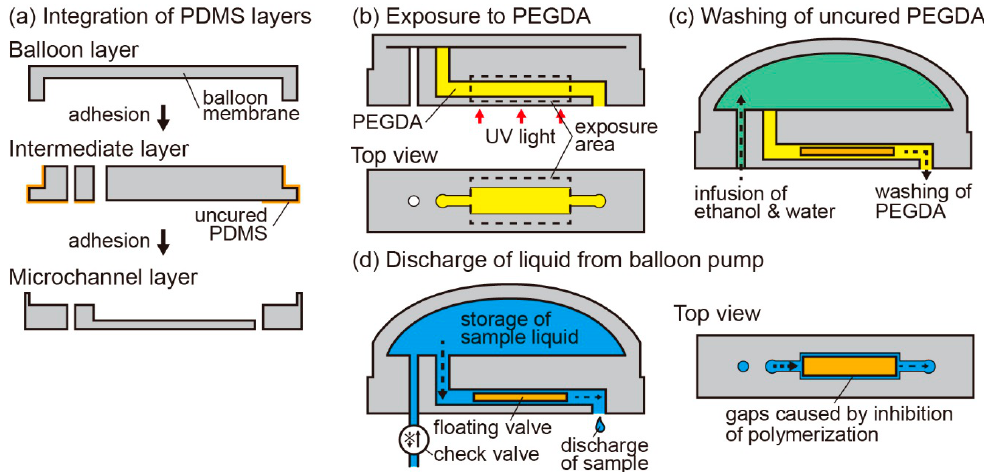
Figure 2. Process flow of the preparation of a balloon pump with a floating valve: ( a ) fabrication of the balloon pump by the integration of polydimethylsiloxane (PDMS) layers; ( b ) solidification of polyethylene glycol diacrylate (PEGDA) using UV light in a microchannel; ( c ) washing of uncured PEGDA using ethanol and water; and ( d ) discharge of the liquid from the balloon pump after the liquid is infused via a check valve.